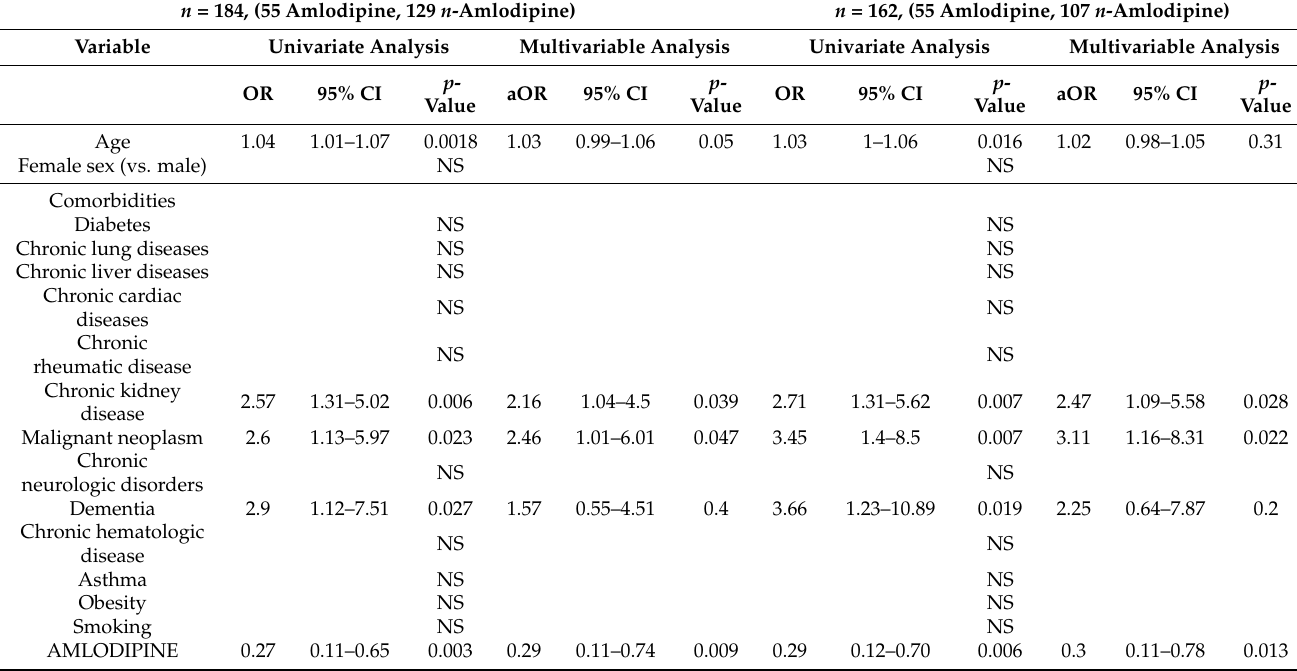
Table 2. Risk factors for mortality among patients with COVID-19 with